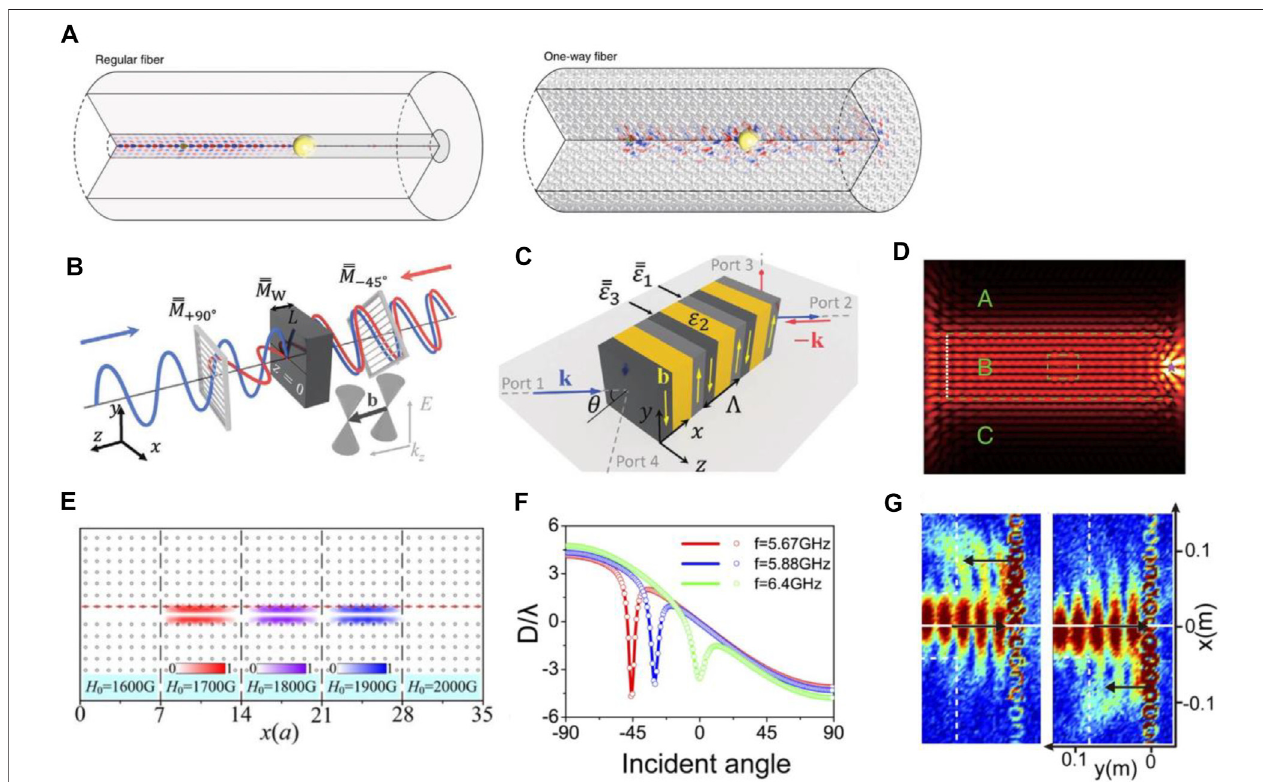
FIGURE 4 | (A) Comparison of a regular fi ber and a one-way fi ber (Lu et al., 2018b). (B) The Faraday isolator and (C) more compact Voigt isolator (Asadchy et al., 2020). (D) Simulated electric fi eld intensity distributions of the one-way large transport at 11.9 GHz in the heterostructures with a void defect (Wang et al., 2021). (E) Electric fi eld pro fi les at the frequencies of 4.292, 4.346, and 4.393 GHz with different magnetic fi eld strengths H 0 (Chen et al., 2019b). (F) The relationship between GH shift,the incident angle and bias magnetic fi eld (Ma et al., 2020). © TheOptical Society. (G) Experimental demonstration ofnonreciprocalproperty ofGH shifteven at normal incidence (Ma et al., 2020). © The Optical